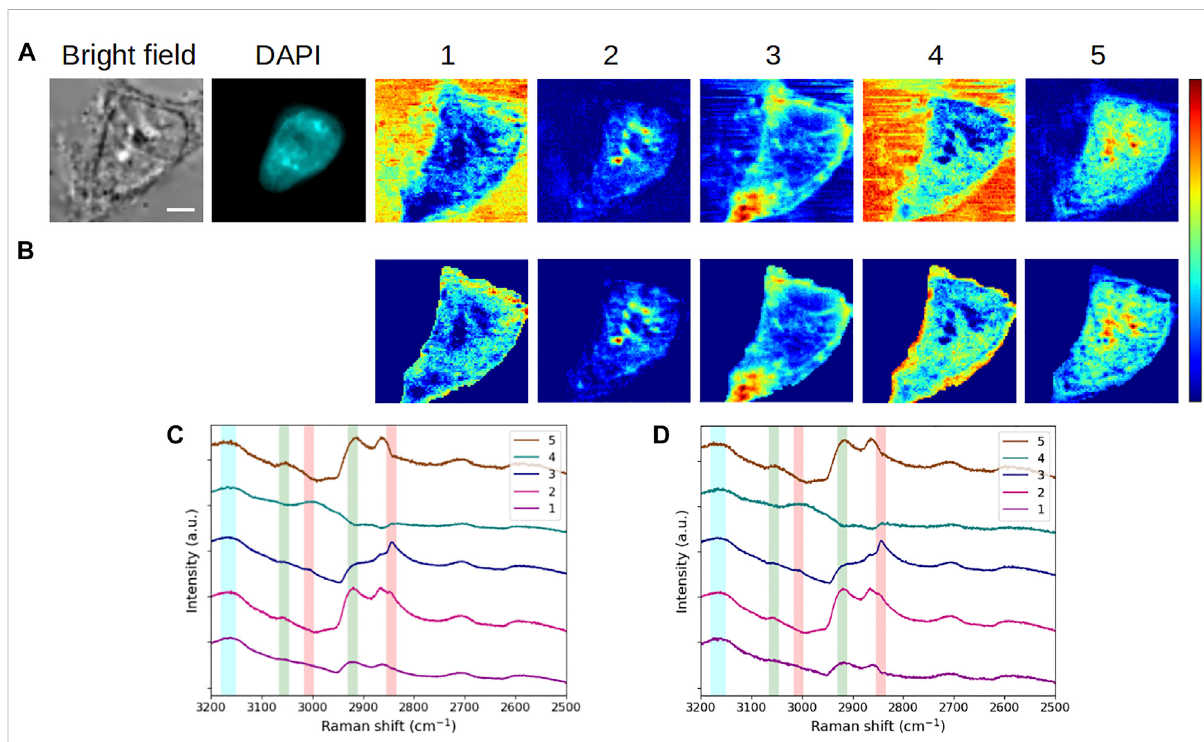
FIGURE 8 Analysis of a fi xed HEK293 cell in interphase (G 1 /S) without or with segmentation. Concentration maps and corresponding spectra obtained by means of (A, C) MC 2 and (B, D) MC 2,S approaches. The scale bar corresponds to 5 μ m. Vertical bars in (C, D) highlight the presence of lipids (red), proteins (green), and water (blue). After fi xation, the cell was stained with